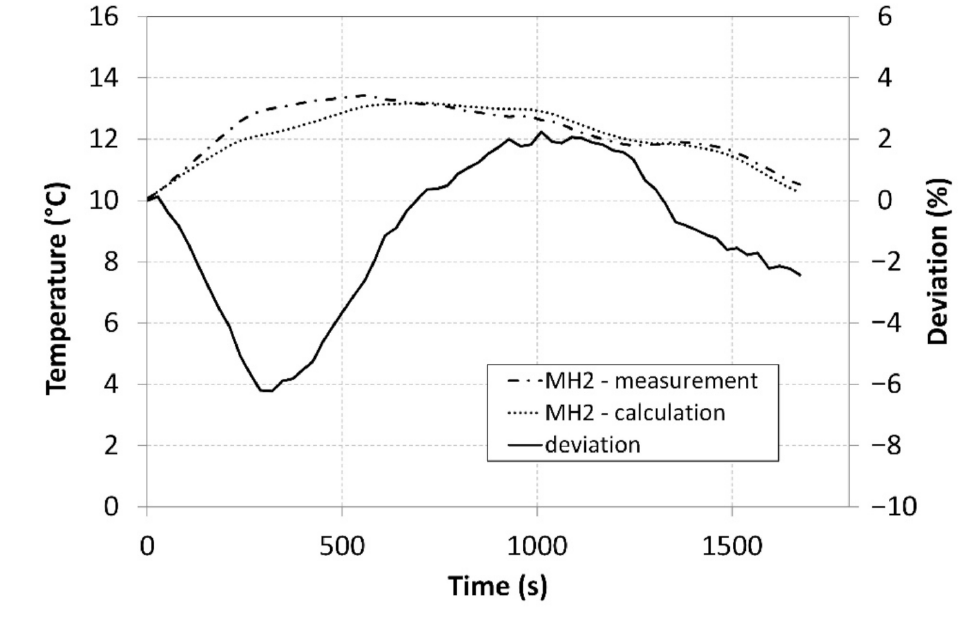
Figure 14. A comparison of the measured and calculated tank